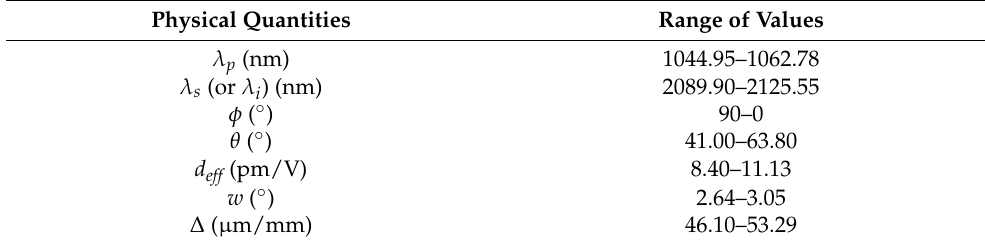
Figure 2. ( a ) Numerical simulation results of the BPM and the group velocity (GV) matching for SPDC in a KN at 22 ° C; ( b ) Type II extended phase matching (EPM) property of KN (the blue line) and its projections on the ϕ - λ p and θ - λ p planes (the green and red lines, respectively). Table 1. The type II EPM properties of KN at 22 ° C: the resonant pump wavelength ( λ p ) and the corresponding signal/idler wavelengths ( λ s and λ i ), the BPM direction ( θ , ϕ ), the effective nonlinear optic coefficient ( d eff ), the spatial walk-off angle ( w ) between the interacting beams, and the beam deviation ( Δ ).